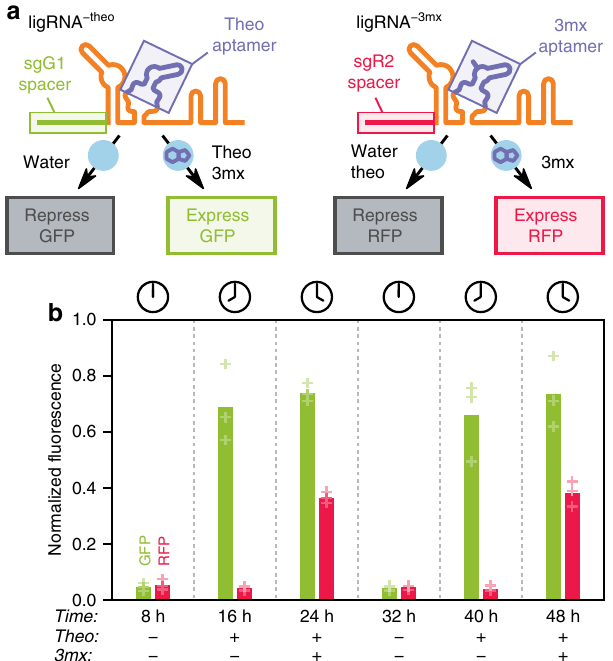
Fig. 4 Multiplexed temporal control of two genes with two